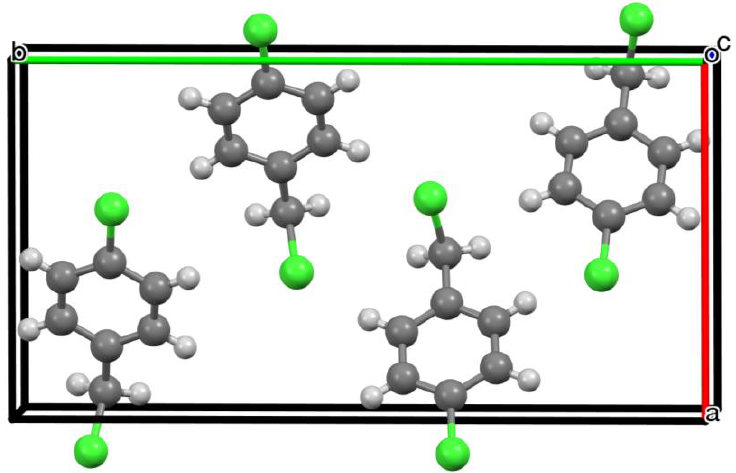
Figure 3. Unit cell of 1 viewed along the c axis showing arrangement of the 4 molecules.